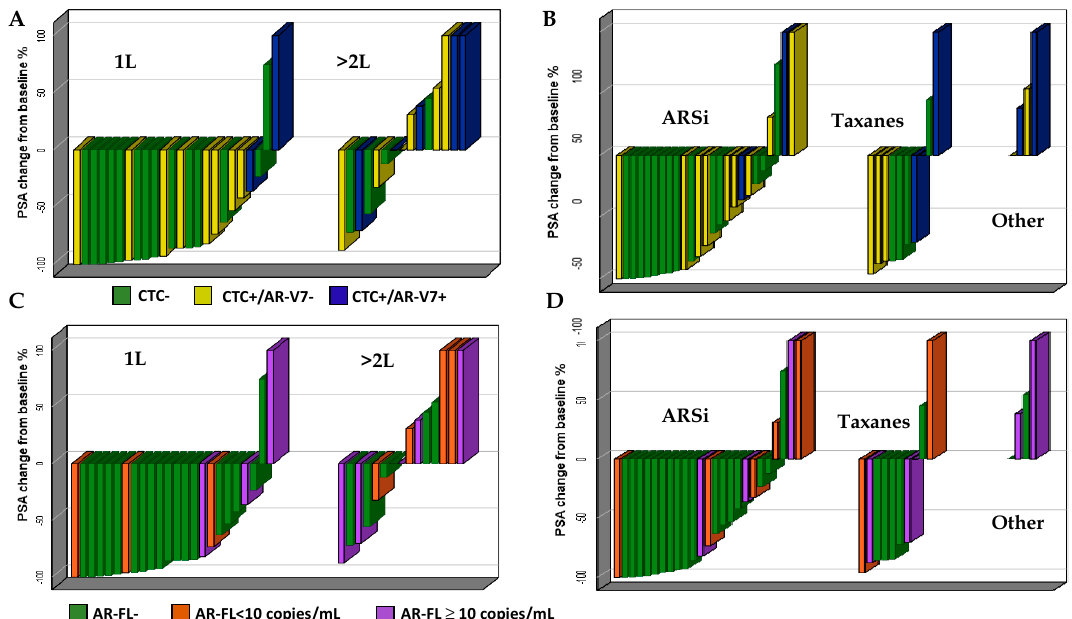
Figure 2. Subgroup analysis. Best PSA response according to CTC and AR-V7 by treatment line ( A ) and type of treatment ( B ) and best PSA response according to AR-FL copies by treatment line ( C ) and type of treatment ( D ).